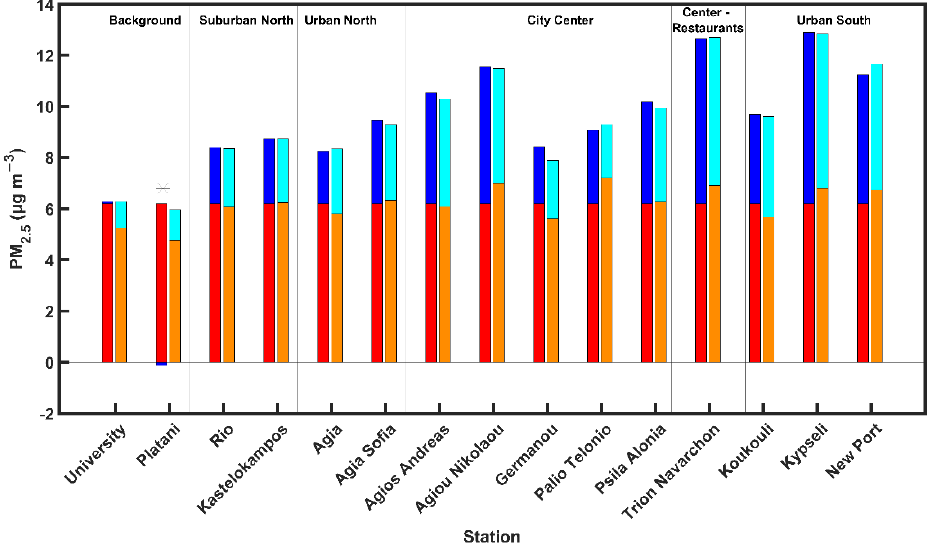
Figure 8. Average estimated contributions of regional transport and local sources to the measured PM 2 . 5 in all stations in Patras. The regional contribution using the difference approach is in red and using the Diamantopoulou et al. [34] approach is in orange. The local contribution using the difference approach is in dark blue and using the Diamantopoulou approach is in light blue.